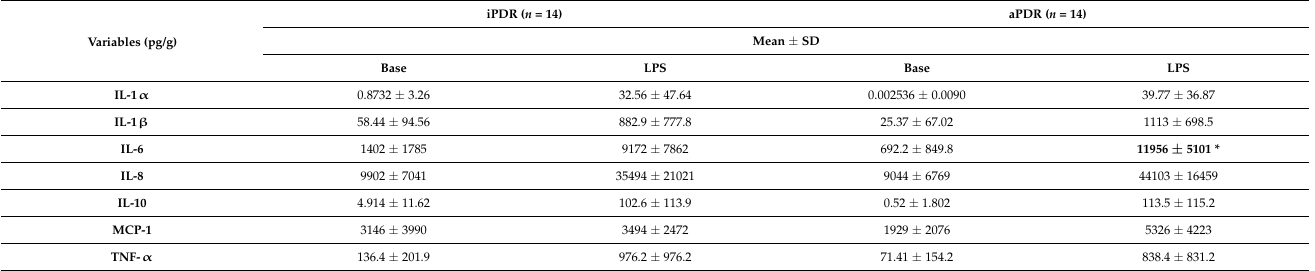
Table A2. Cytokine secretion of PBMCs from iPDR and aPDR patients into culture supernatant under non-stimulated and endotoxin-stimulated (LPS) conditions.